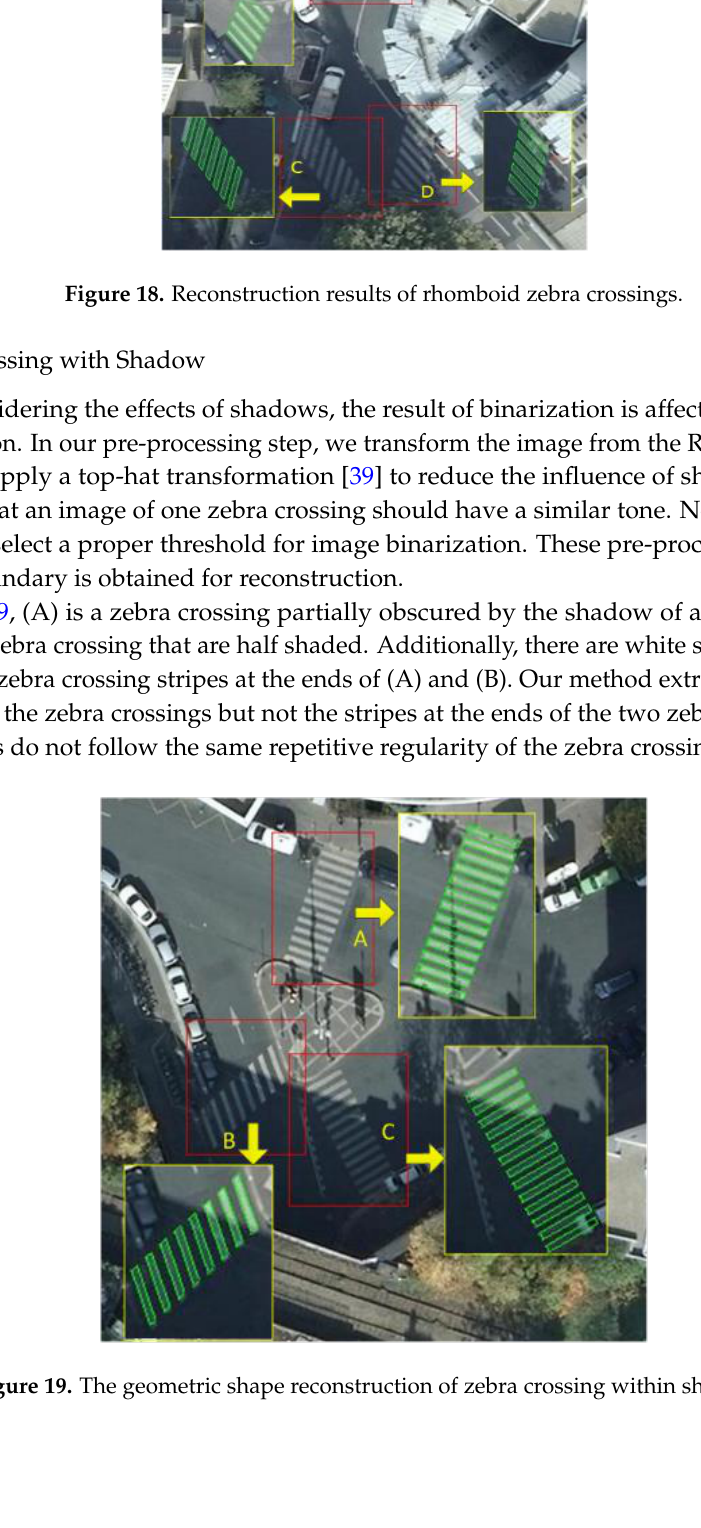
Figure 17. The results of zebra crossing reconstruction in green lines.